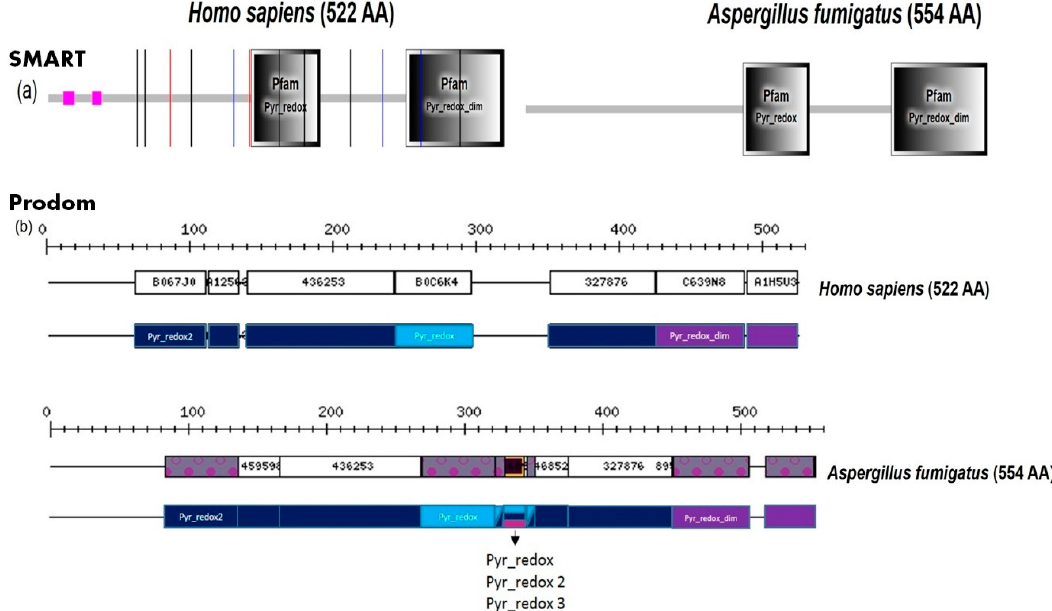
Figure 3. Protein domain analysis of the glutathione reductase showing the similarities between human (UniProt ID: P00390) and A. fumigatus protein (UniProt ID: A0A0J5PGY5). Panel ( a ) Both proteins contain a Pyridine nucleotide-disulphide oxidoreductase domain (Pyr_redox; position 233–314 in human, position 261–341 in Aspergillus ) and the Pyridine nucleotide-disulphide oxidoreductase, dimerization domain (Pyr_redox_dim; position 411–522 in human, position 439–554 in Aspergillus ). Magenta square: low complexity region, black line: intron (phase 0), blue line: intron (phase 1), red line: intron (phase 2). The analysis was performed by SMART database; Panel ( b ) Domain mapping performed by ProDom database. We enlarged the standard output so that now the specific minor differences in exact domain composition and position of low complexity regions and other features stand out.